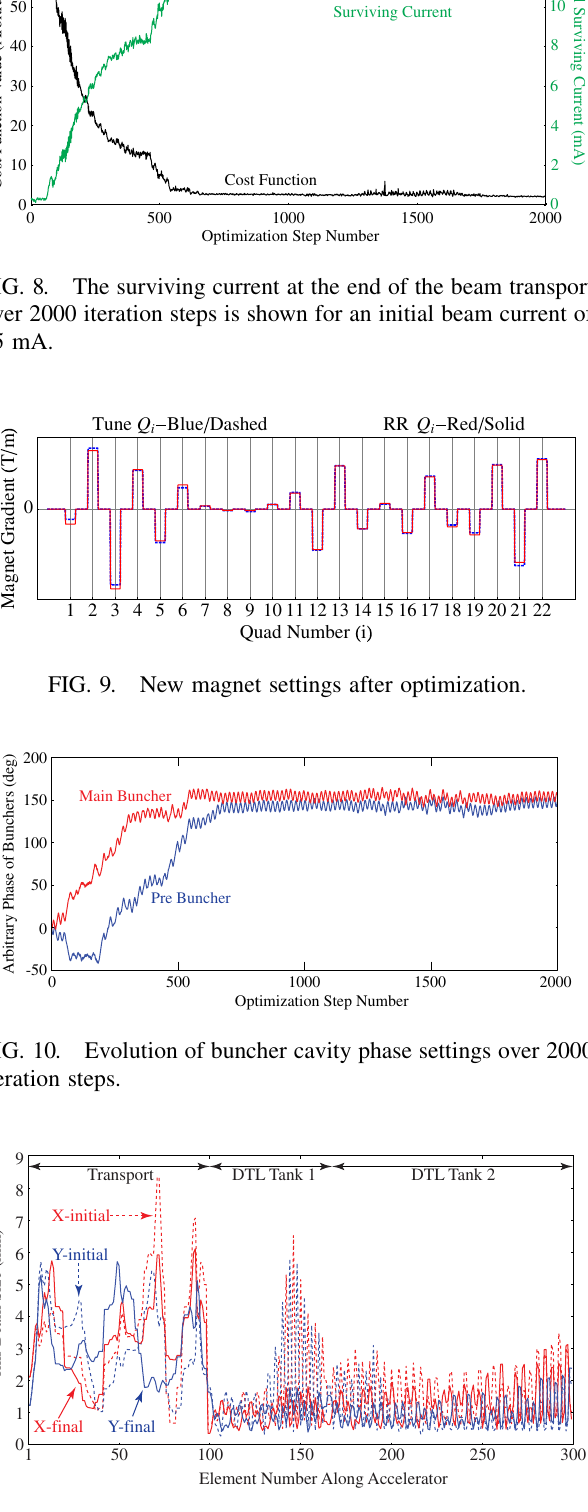
FIG. 11. Comparison of rms beam size along the accelerator for the 2011 tune-based magnet settings and arbitrary phase (dashed) with rms beam size following RR tune (solid).